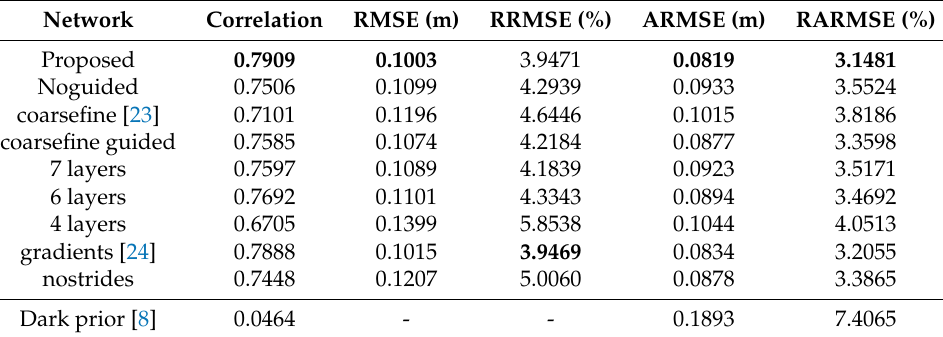
Table 2. Results of different neural network architectures on dataset